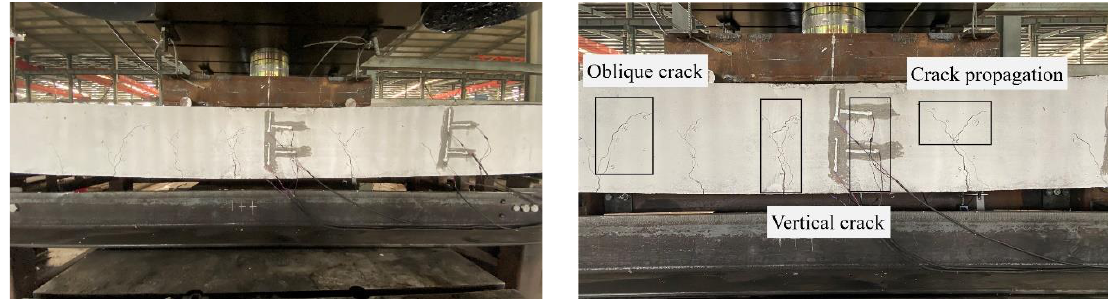
Figure 8. Failure characteristics of the JSC50 × 6 component.